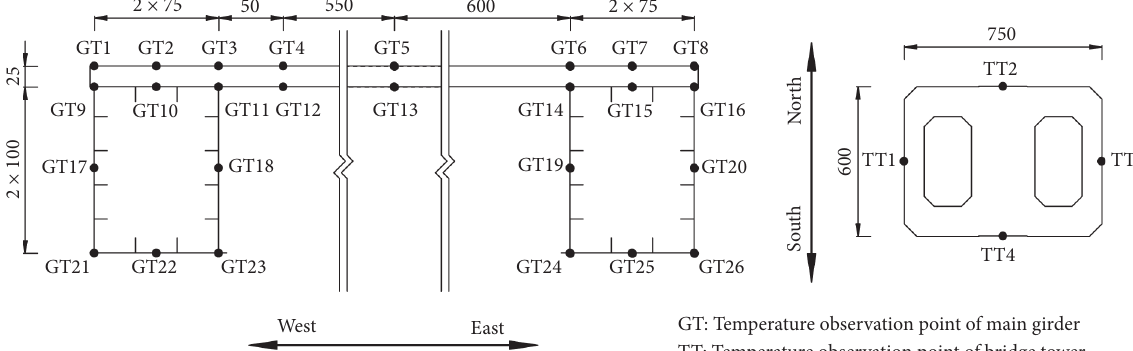
Figure 8: The location of temperature observation points.